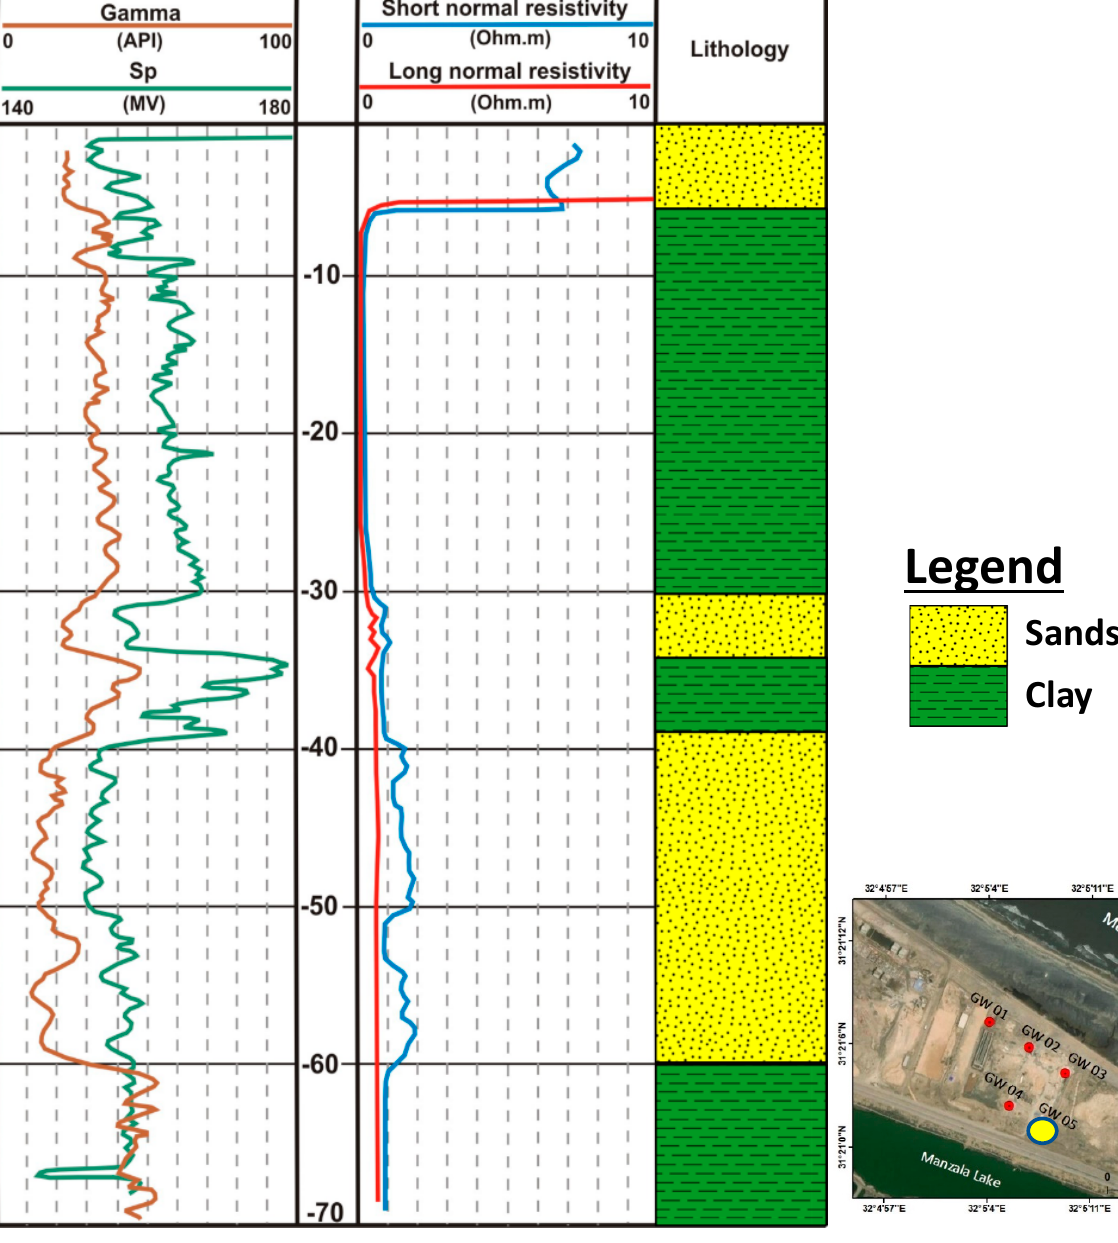
Figure 10. Gamma ray, SP, resistivity logs and the corresponding lithology in well GW05.